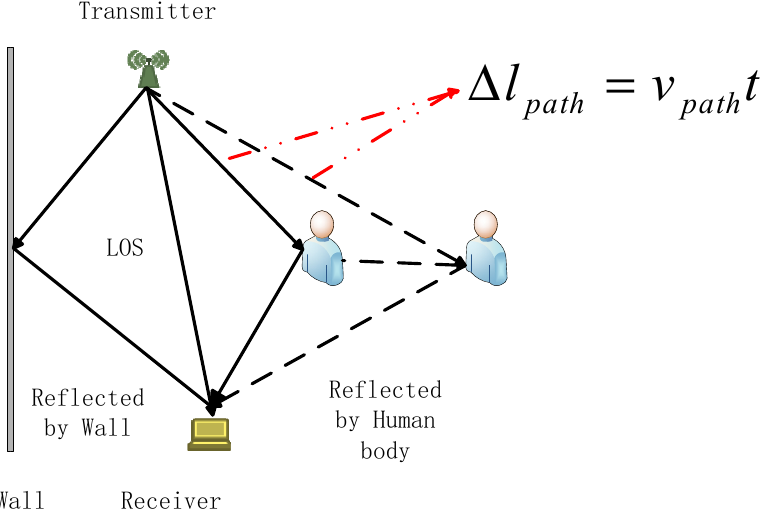
Figure 5. The Rayleigh fitting parameter before and after removing the noise of AGC in the silence environment ( a ) The Rayleigh fitting parameter before removing the noise of AGC; ( b ) The Rayleigh fitting parameter after removing the noise of AGC.